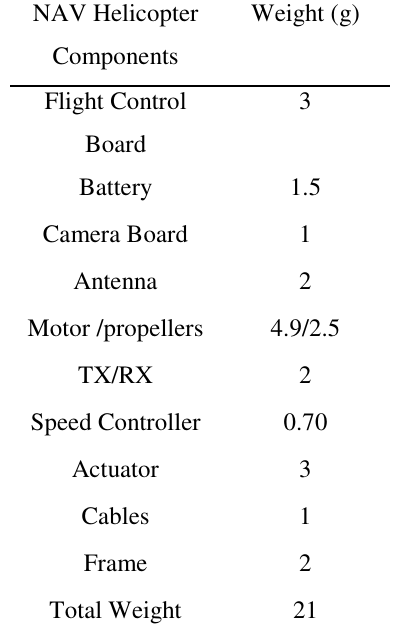
Table 1: materials list of NAV and their weight